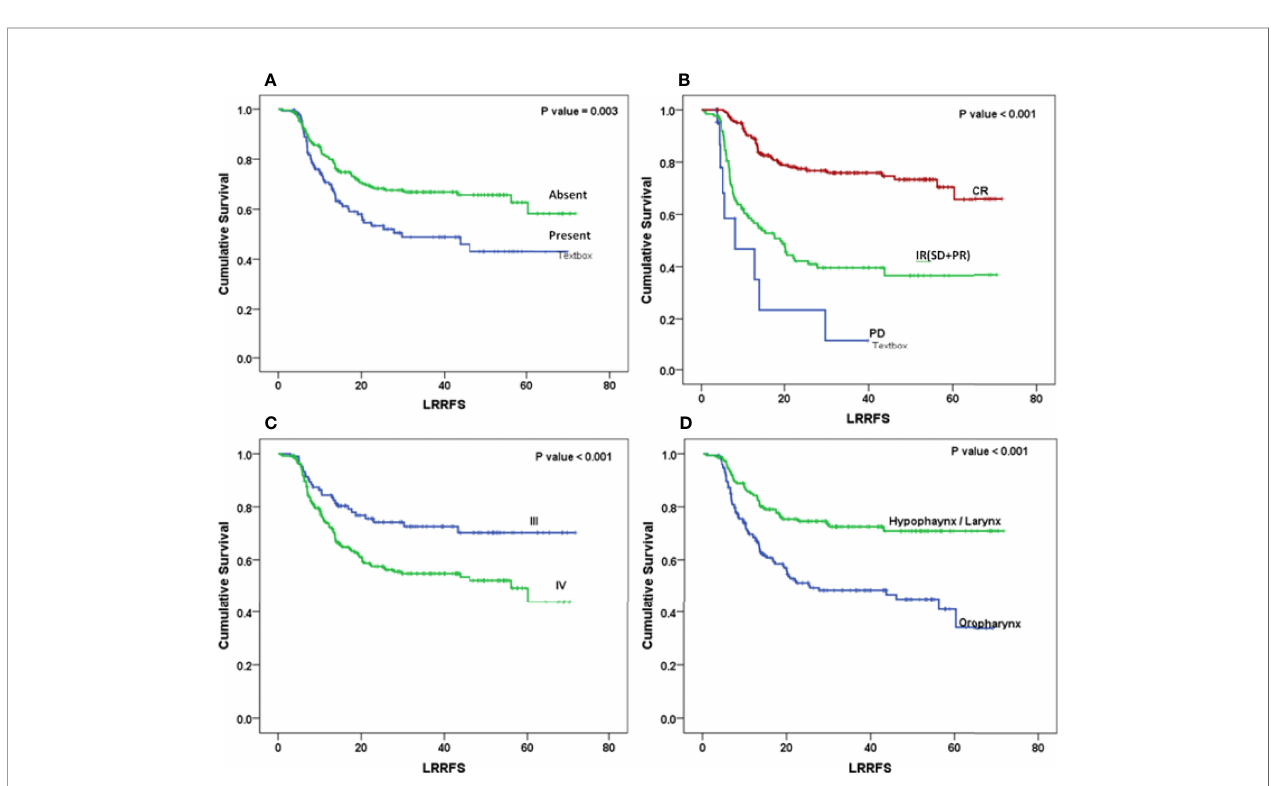
FIGURE 7 | Kaplan – Meier survival curves showing locoregional recurrence-free (LRRFS) survival by clinical factors: (A) rENE, (B) response, (C) overall stage, and (D)